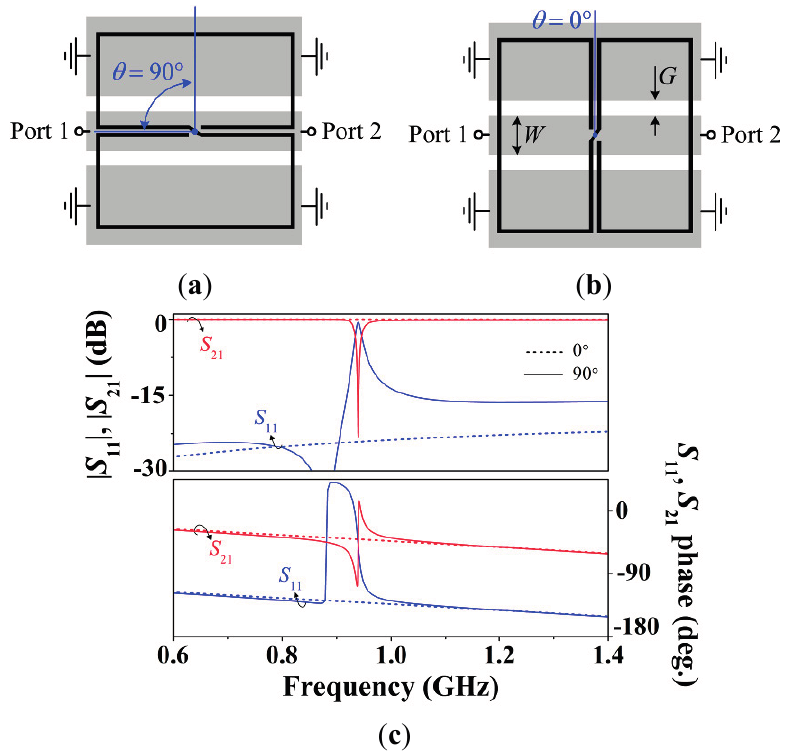
Figure 2. CPW loaded with an S-SRR for ( a ) 90° and ( b ) 0° angular orientations, and ( c ) lossless transmission and reflection coefficients. The angular orientation between the CPW and the S-SRR is determined by the angle 0° ≤ θ ≤ 90°, where the S-SRR center is taken as the rotation axis crossing the CPW axis. CPW dimensions are: W = 2 mm and G = 0.78 mm (50- Ω line). S-SRR dimensions, as denoted in Figure 1, are: c = s = 0.2 mm and l 1 = l 2 = 10 mm. The substrate is Rogers RO3010 with thickness h = 1.27 mm and dielectric constant ε r =